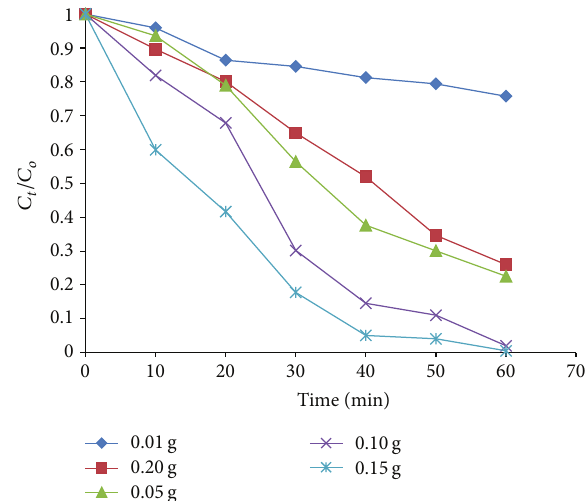
Figure 2: The effect of dosage and contact time of AC1 on the removal of BBG